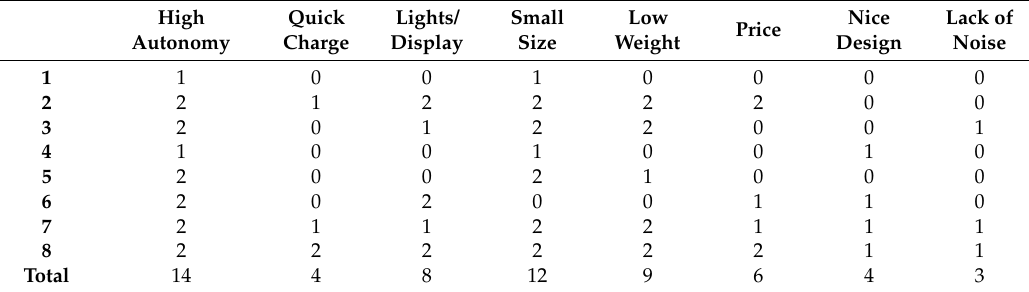
Table 6. Second Use of Interrelation Matrix: Relative Important Chart.